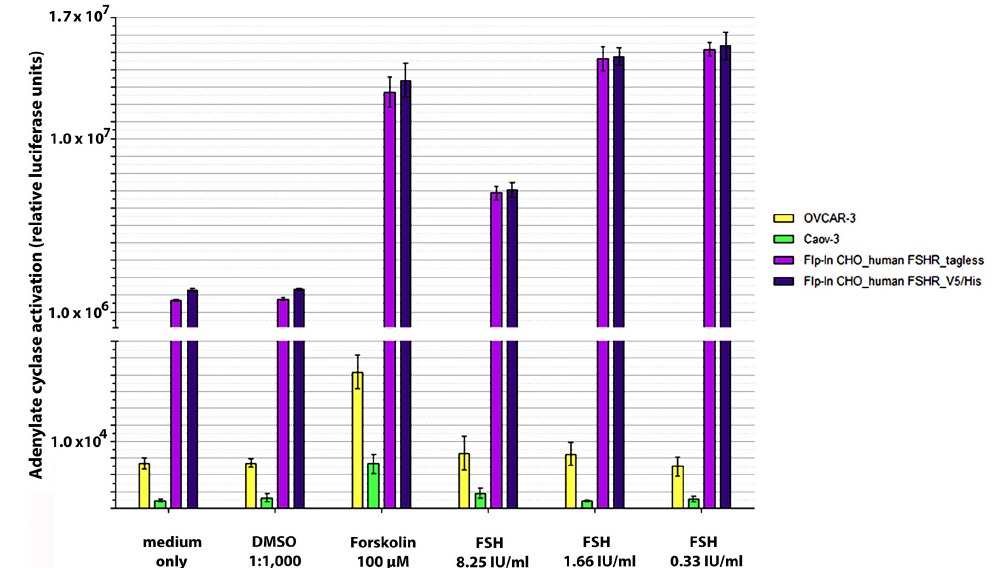
Figure 1. Detection of functional follicle ‐ stimulating hormone (FSH) ‐ receptor (FSHR) on the surface of different cell lines: Cyclic AMP signaling in response to FSH. Flp ‐ In CHO cells expressing the hFSHR, OVCAR ‐ 3, and Caov ‐ 3 were treated with controls or different concentrations of FSH. The cAMP was measured by cAMP reporter gene assay (see Section 4). Controls: medium, dimethyl sulfoxide (DMSO) as negative controls; forskolin as assay positive control.